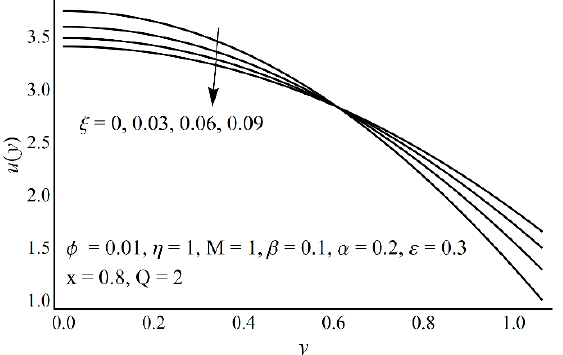
Figure 3. Axial velocity for various values of velocity slip parameter ξ .